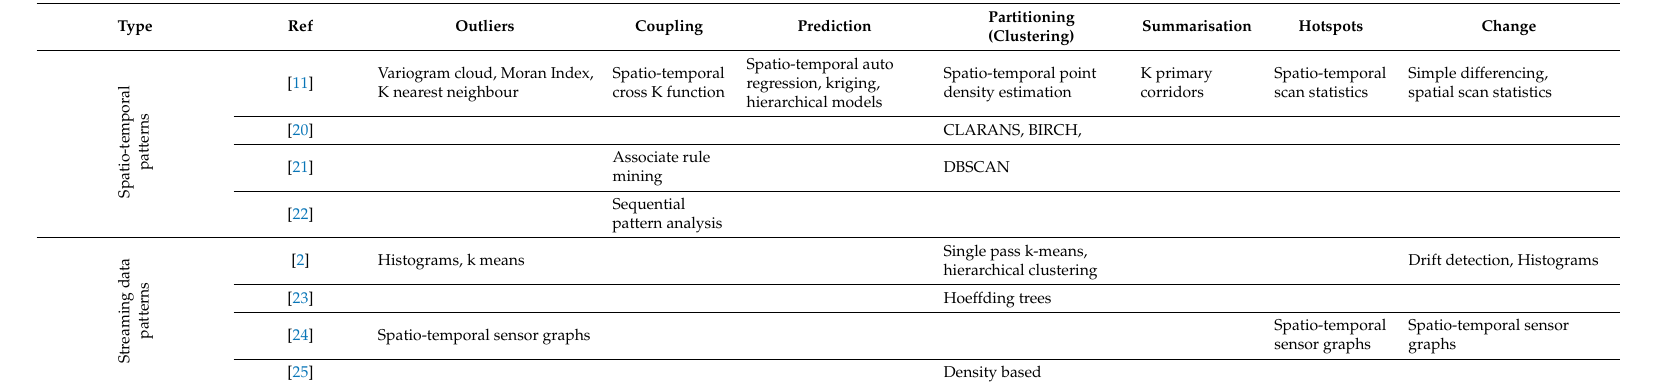
Table 2. An overview of the review of pattern seeking analytic